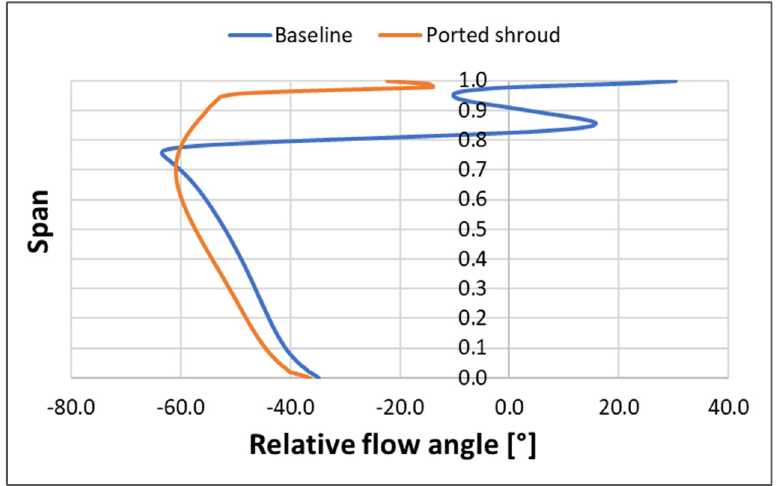
Figure 15. Comparison of the hub-to-shroud distribution of the relative flow angle at the leading edge between the configurations with ported shroud and baseline, at near surge condition OP2.